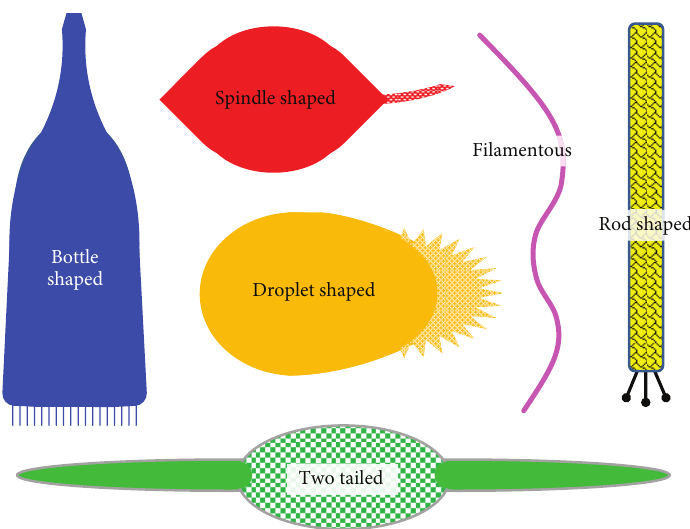
F 3: Schematic representation of various Crenarchaeotavirion morphologies. Reading clockwise from the le, bottle shaped (blue) is the morphology of family Ampullaviridae. e spindle shape is associated with family Fuselloviridae as well as the otherwise unassigned genus Salterprovirus (red). e enveloped Lipothrixviridae are �lamentous (fuchsia), with various end-cap adornments not shown. ere are four genera associated with this family, Alphalipothrixvirus , Betalipothrixvirus , Gammalipothrixvirus , and Deltalipothrixvirus , with the Alphalipothrixvirus virions somewhat broader relative to length than the others. e rod-shaped viruses, yellow with black ornamentation, are members of family Rudiviridae. Note the terminal �bers located in the �gure at the bottom of the virion. e two-tailed virus (green) is classi�ed as a member of family Bicaudaviridae. Its tails form morphologically only following virion release from its parental cell. Lastly, family �uttaviridae (orange, middle) possess droplet-shaped virions, shown with representations of �bers starburst shape found at their “tail” (right) end. Virions are not drawn to